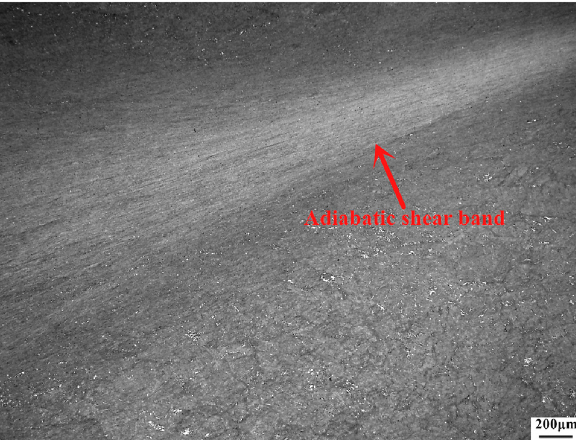
Figure 15: Correlation between predicted stress and experimental stress.